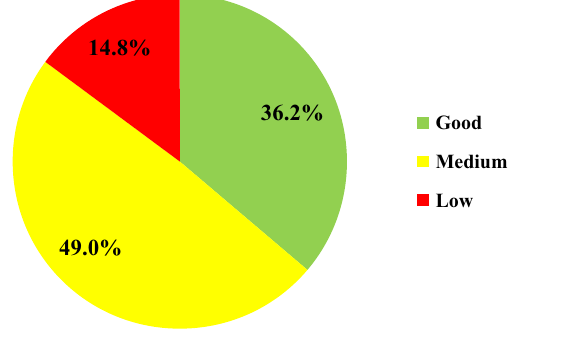
Fig. 5 Assessment of pipe ages